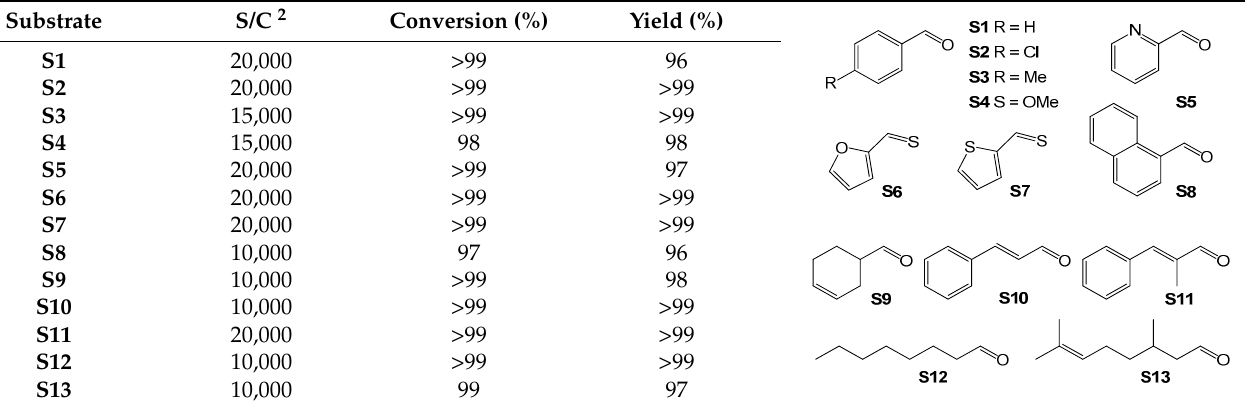
Table 3. Results of the catalytic hydrogenation reaction 1 of aldehydes in the presence of [Fe(PNP-Me- i Pr)(CO)(H)(Br)] tested by Kirchner et al. [93]. Substrate